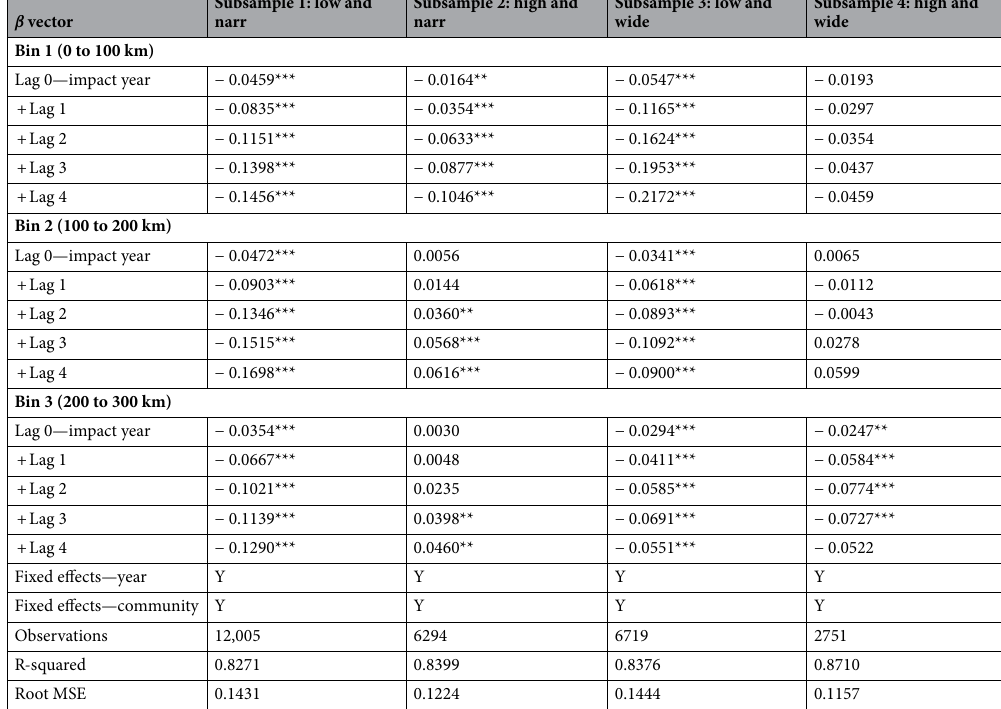
Table 1. Five-year cumulative effects of cyclone exposure on growth rate in economic activity across four subsamples (low and high elevation coastal communities, narrow and wide mangroves) and three bins of direct and indirect exposure (“eye” of the storm passing within 100 km, 100–200 km and 200–300 km of coastal community). All specifications report cumulative effects with robust standard errors, four autoregressive lags in addition to the year of exposure, two forward lags on cyclone exposure and controls for mangrove width and the baseline logged growth rate. “Low” sub-samples contain coastal communities with a mean elevation < 50 m, and “high” have a mean elevation ≥ 50 m. “Narrow” sub-samples contain coastal communities with an average mangrove width from the seaward boundary of < 10 m per m of coastline, and “wide” an average mangrove width of ≥ 10 m per m of coastline. **p < 0.05, ***p <